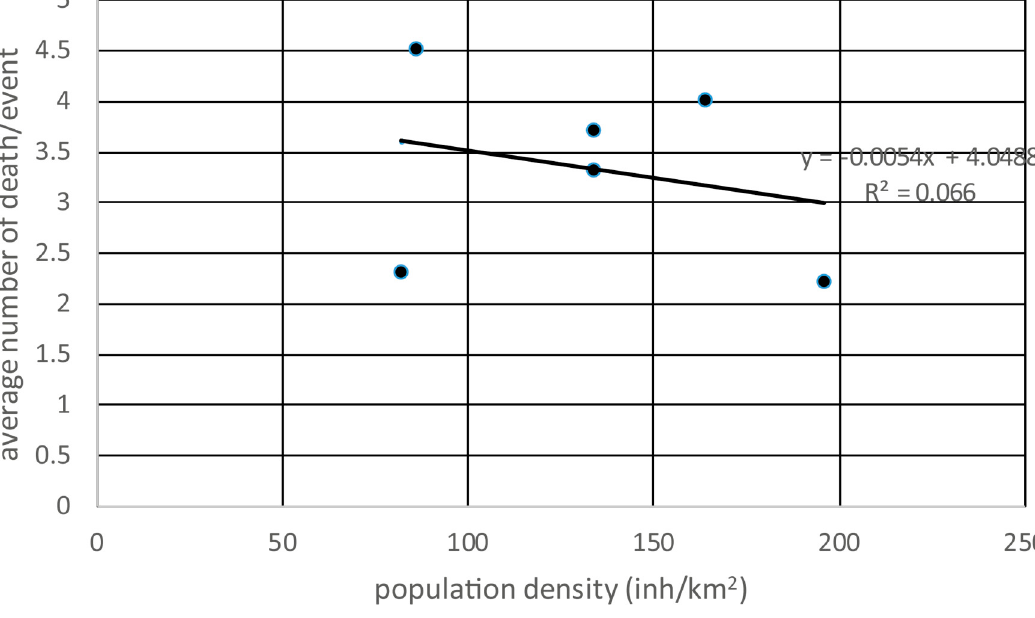
Figure 15. Relationship between the average number of deaths per event and the population density.